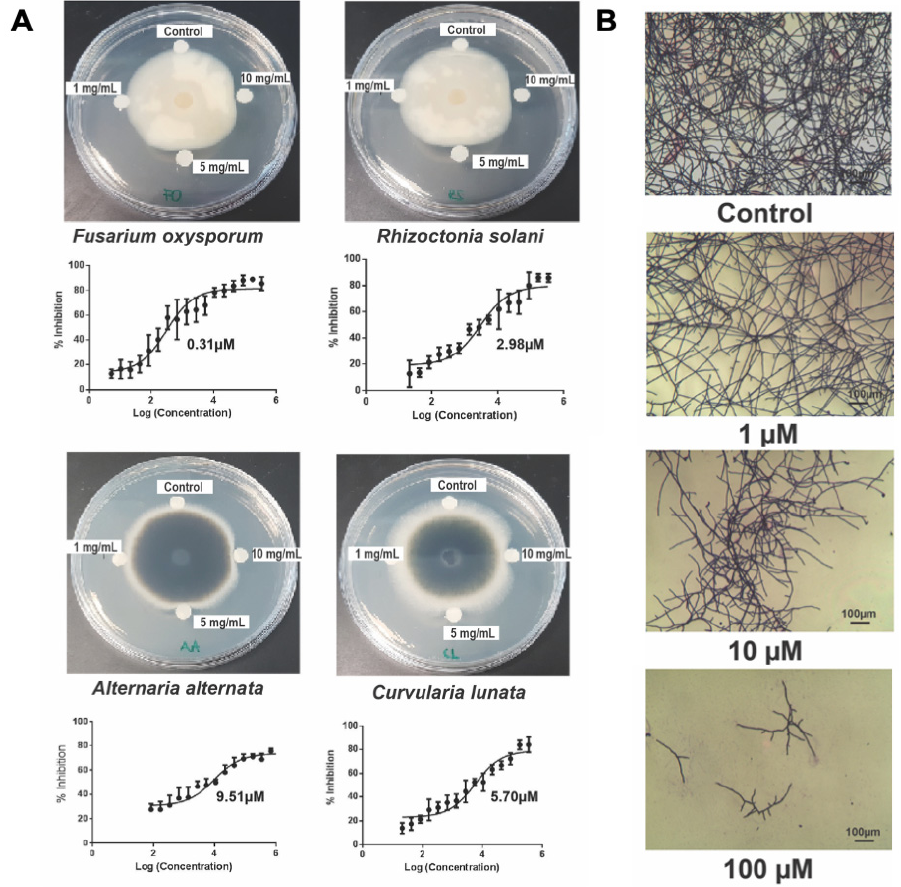
Figure 6. Chenotide cQ2 is an anti-fungal peptide. ( A ) Fungal inhibition of chenotide cQ2 against Fusarium oxysporum , Rhizoctonia solani , Alternaria alternata and Curvularia lunata . Formation of arc- shaped inhibition zones in the disc diffusion assay indicated susceptibility of fungi towards chenotide. The IC 50 was calculated based on the dose-response curve obtained from the micro-broth dilution assay. ( B ) Bright-field microscopy of hyphal growth inhibition with chenotide cQ2. Fusarium oxysporum treated with different concentrations of chenotide cQ2. Formation of stunted hyphae ends indicated that chenotide inhibits hyphal growth at the ends of the fungal mycelia.